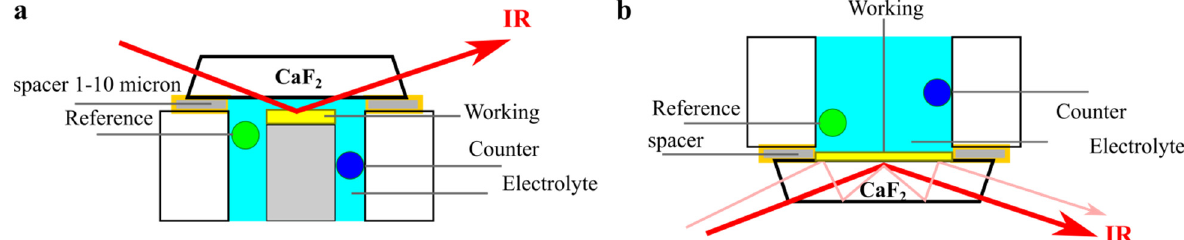
Figure 6. Schematic representation for ( a ) SEIRAS setup through the electrode’s front side. ( b ) ATR setup through electrode’s back side. The incident IR (pink color) can be tuned to have multipath inside the prism to increase the signal to noise intensity.